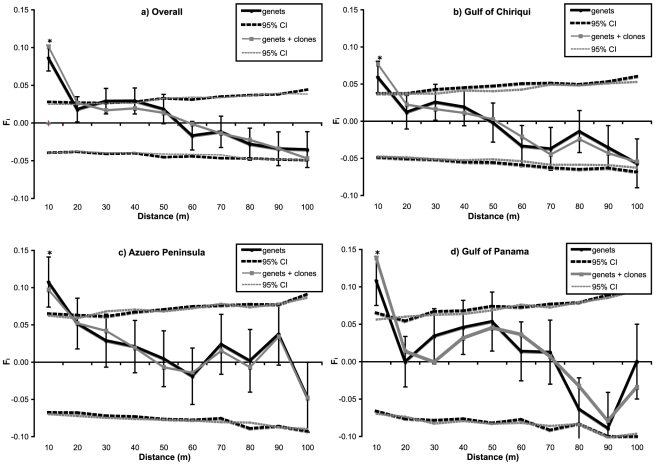
Spatial correlograms of the SpaGeDi [145] analysis of Spatial Genetic Structure (SGS) among specimen within discrete distance classes.Black lines represent the genet dataset, excluding clones and grey lines show the results for the ramet dataset, including clones. Dashed lines are the permuted 95% confidence intervals. Error bars are 95% bootstrap errors of the genet datasets.
Figure 3a
) Spatial correlogram of the average pairwise kinship Fij
[146] as a function of distance over all populations.
Figure 3b–d
) Spatial correlograms over the populations in each of the three regions, b) the Gulf of Chiriqui, c) the Azuero Peninsula and d) the Gulf of Panama.